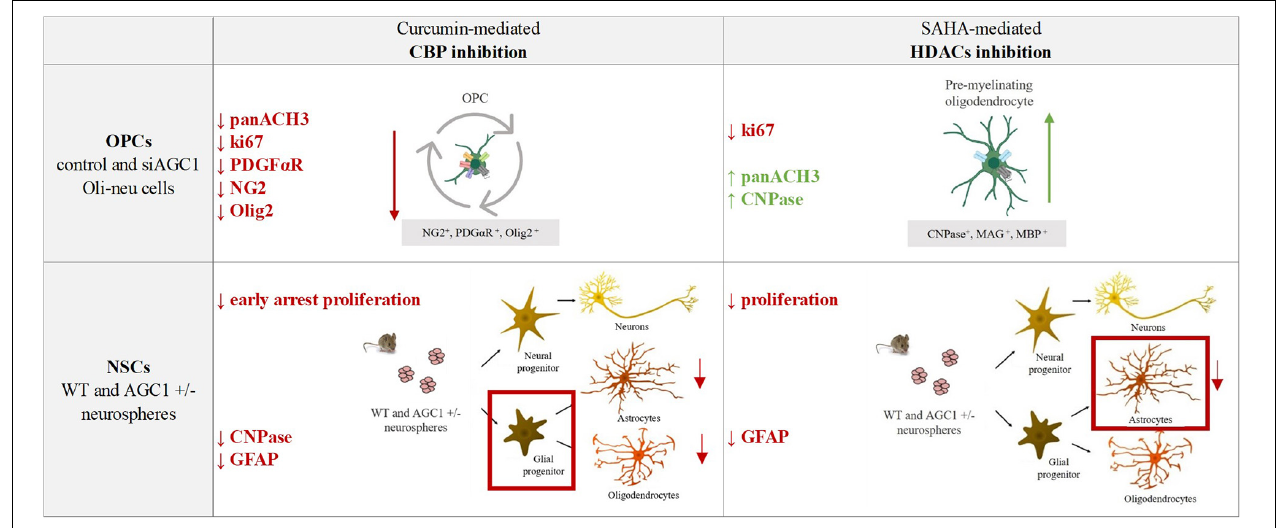
FIGURE 12 | Summary table of increased/decreased markers involved in OPCs and NSCs proliferation/differentiation following curcumin-mediated CBP inhibition and SAHA-mediated HDACs inhibition in control and siAGC1 Oli-neu and WT and AGC1 ±